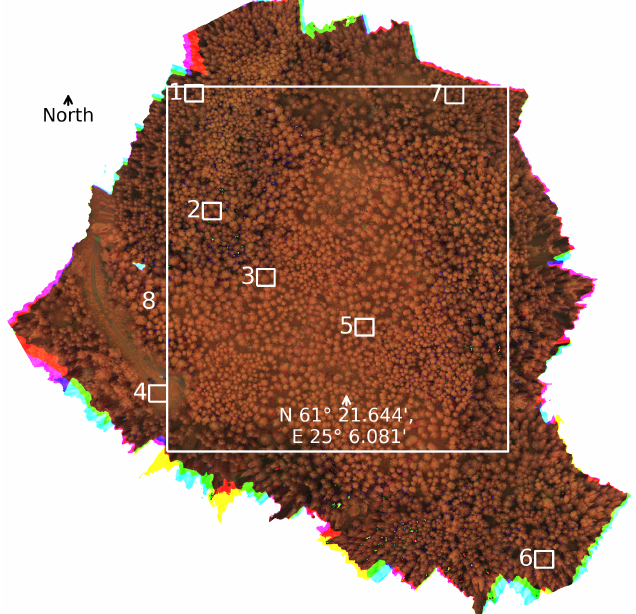
Figure 5. Plots selected for in-depth analysis plotted over a false color image of the research forest. The wavelength bands used in making the figure are approximately 800nm, 700nm, and 500nm. The edges show a rainbow artefact produced by some of the bands being empty in the plot. Plots 1, 5, and 6 are in a spruce-dominated plot, plots 2, 3, and 5 are in a birch-dominated plot and plot 4 is on a forest road. Plot 8 is a larger plot that consists mainly of birch forest, while having a significant amount of spruce on the border